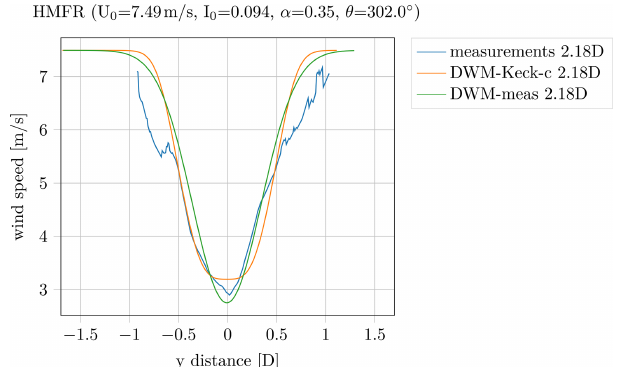
Figure 6. Wind speed deficit in the HMFR, measured and simu- lated with the calibrated DWM-Keck-c model as well as fitted to a Gaussian-shaped wake model